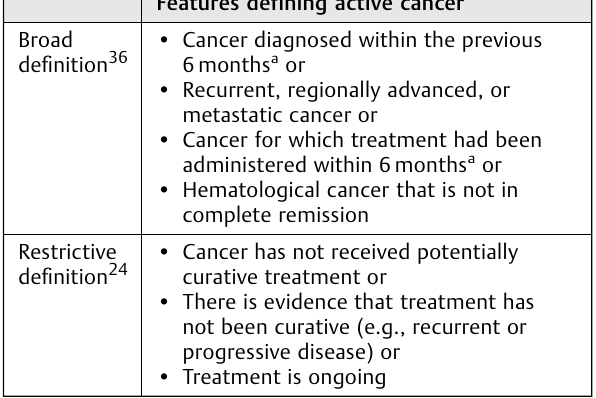
Table 2 De fi nitions of active cancer in patients to be included in cancer-associated thrombosis trials Features defining active cancer